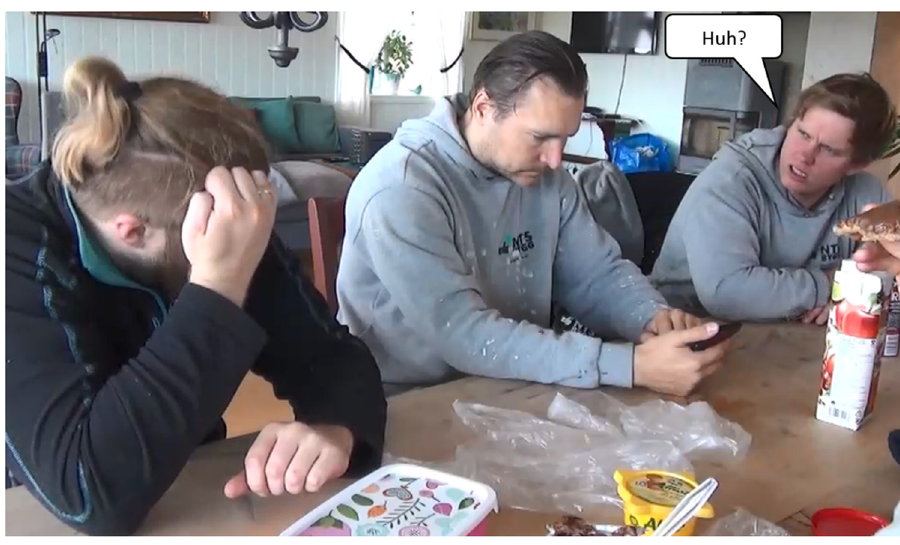
Figure 11: Carl upgrading to an explicit, open - class, nonmanual repair initiation. ( End of line 9. )